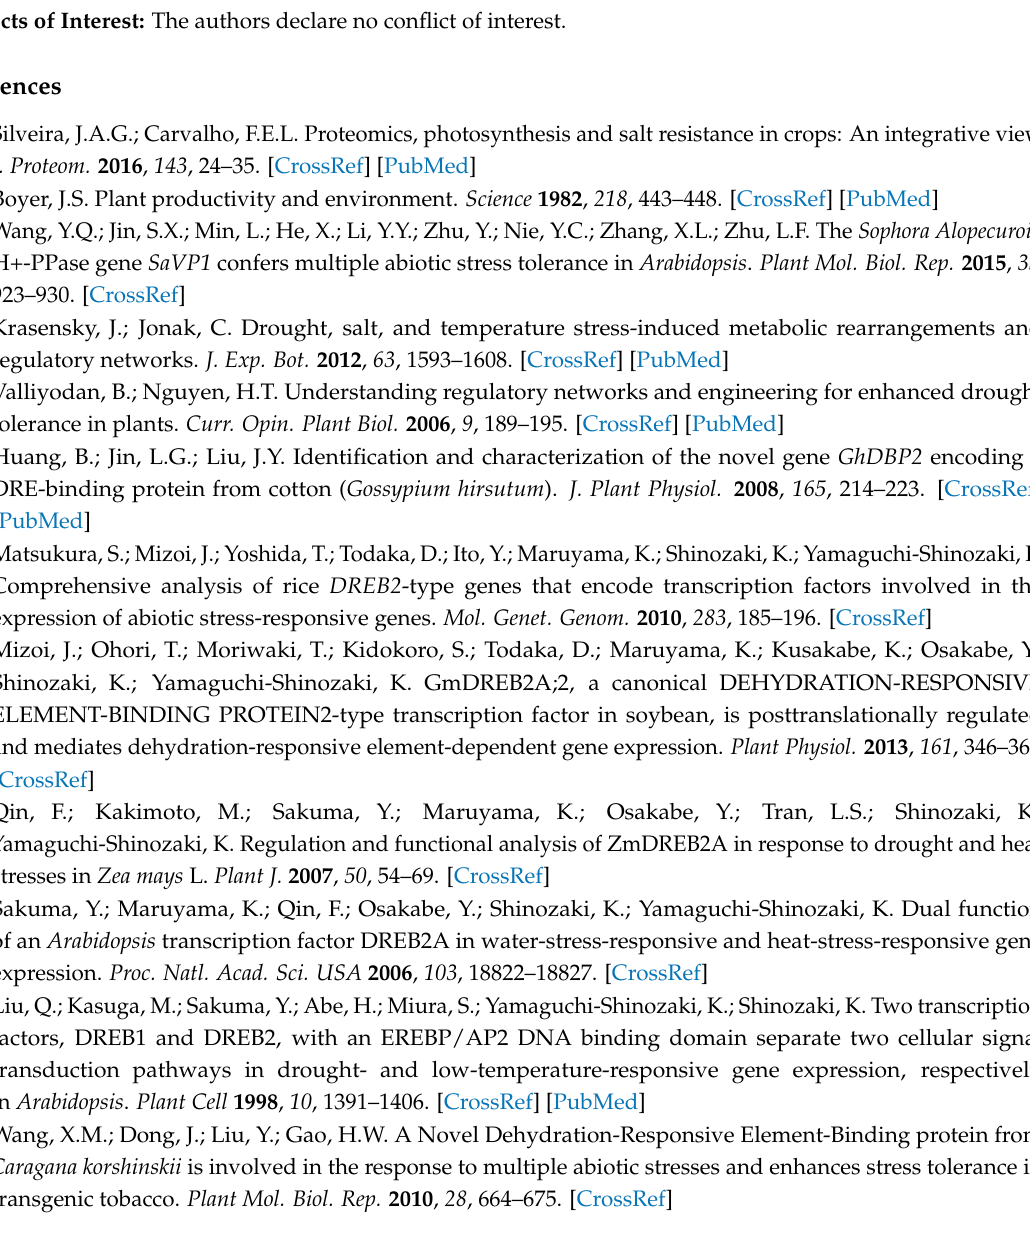
Figure S1: Molecular identification of the ScDREB10 transgenic Arabidopsis lines, Table S1: List of primers used for vector construction, Table S2: List of primers used for real-time PCR, Table S3: Sequence similarity analysis of 22 DREB proteins and estimates of evolutionary divergence between